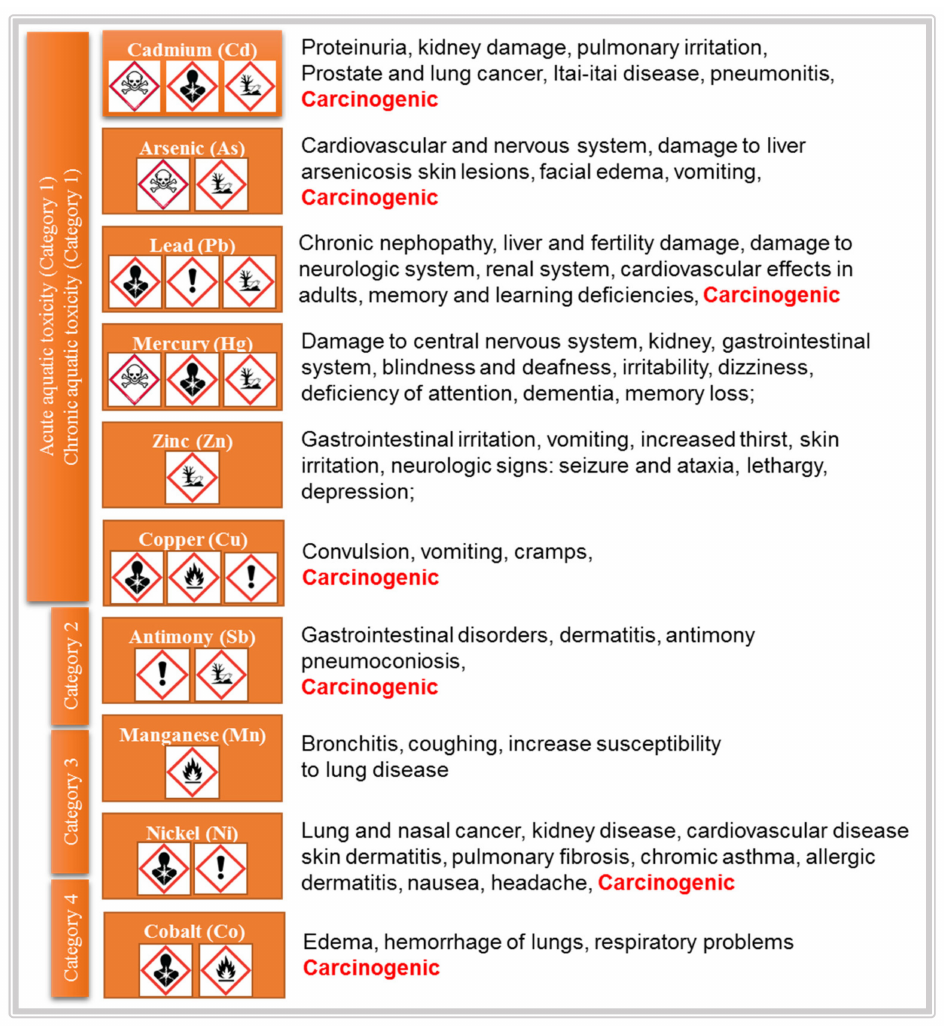
Figure 1. Illustration of the main heavy metal ions (HMIs) present in wastewaters, which are listed according to their toxicity, with pictograms and main health hazards for each element, according to the United Nations Guide to the Globally Harmonized System of Classification and Labeling of Chemicals (GHS)